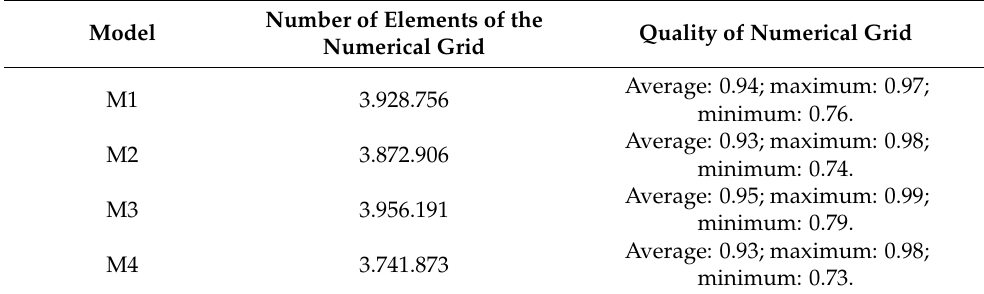
Figure 2. Details of the dimensions of the computational domain. Table 2. Size and quality parameters of the numerical grids established in the simulations of each dryer